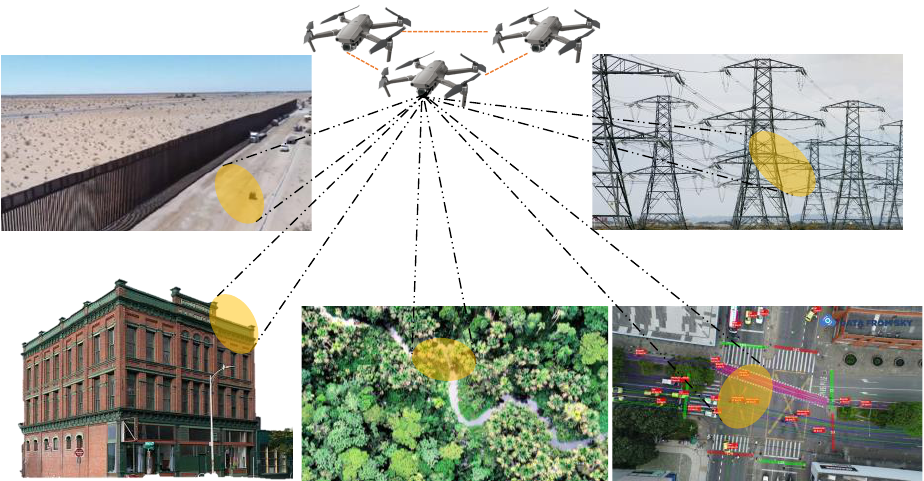
Figure 1. Typical application scenarios for UAV surveillance, including border patrol, construction management, power grid inspection, and traffic and environmental monitoring.